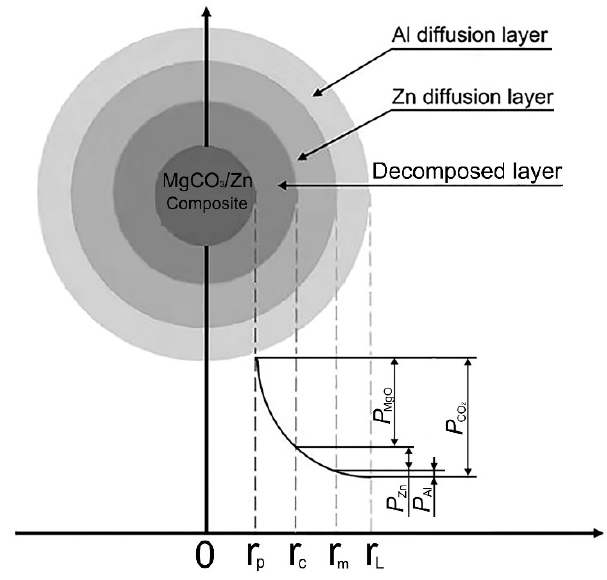
Figure 2. The decomposition of the MgCO 3 /Zn composite powder and TiH 2 powder under two conditions: ( a ) constant temperature heating and ( b ) continuous temperature heating.